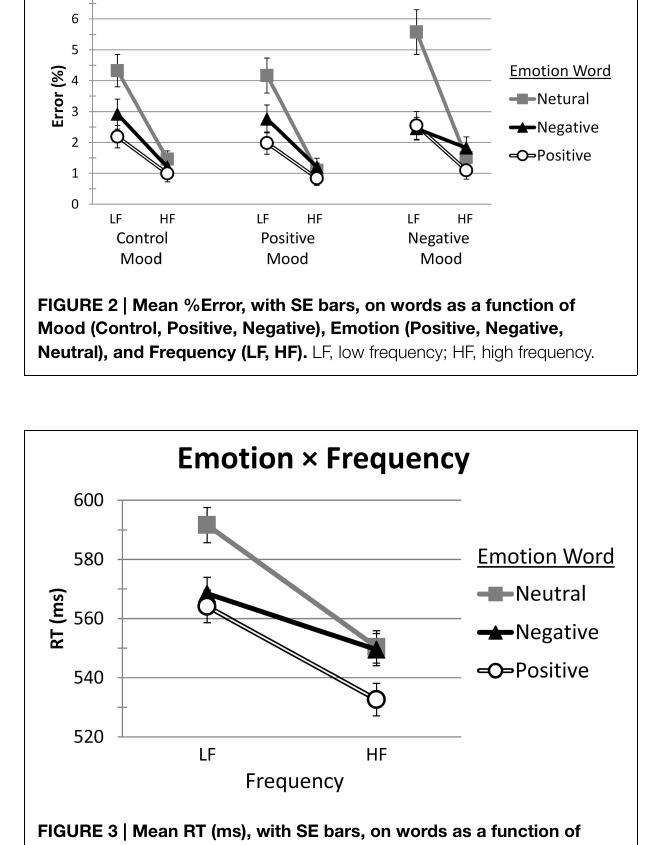
FIGURE 3 | Mean RT (ms), with SE bars, on words as a function of Emotion (Positive, Negative, Neutral) and Frequency (LF, HF). LF, low frequency; HF, high frequency.